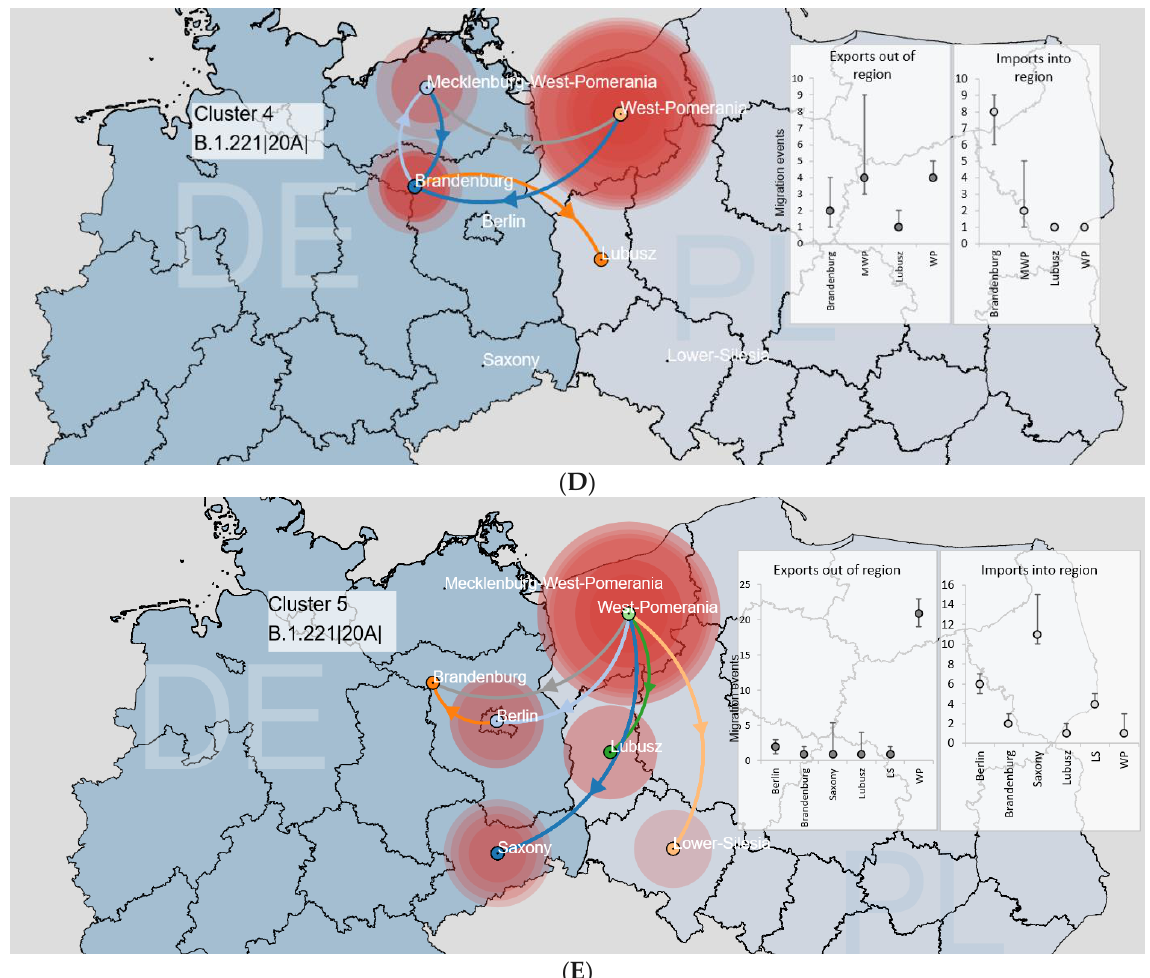
Figure 5. Reconstruction of the dispersal history of ( A ) Cluster 1 (B.1.1|20B|), ( B ) Cluster 2 (B.1.258|20A|), ( C ) Cluster 3 (B.1.258|20A|), ( D ) Cluster 4 (B.1.221|20A) and ( E ) Cluster 5 (B.1.221|20A) among the Polish – German border area using a discrete diffusion model. Each of the seven regions is indicated by a (centroid) circle with different colours, and inward movements to a particular location are depicted in the same colour with an arrow. The sizes of the polygons around the sampling centres are proportional to the number of viruses that maintain a specific area. The charts show a median number of transitions out of and into each region, as inferred using a Markov jumps estimation with the 95 % HPD intervals shown as lines. All migration events between locations are supported by Bayes Factor values ≥3, except for lines indicated in grey.